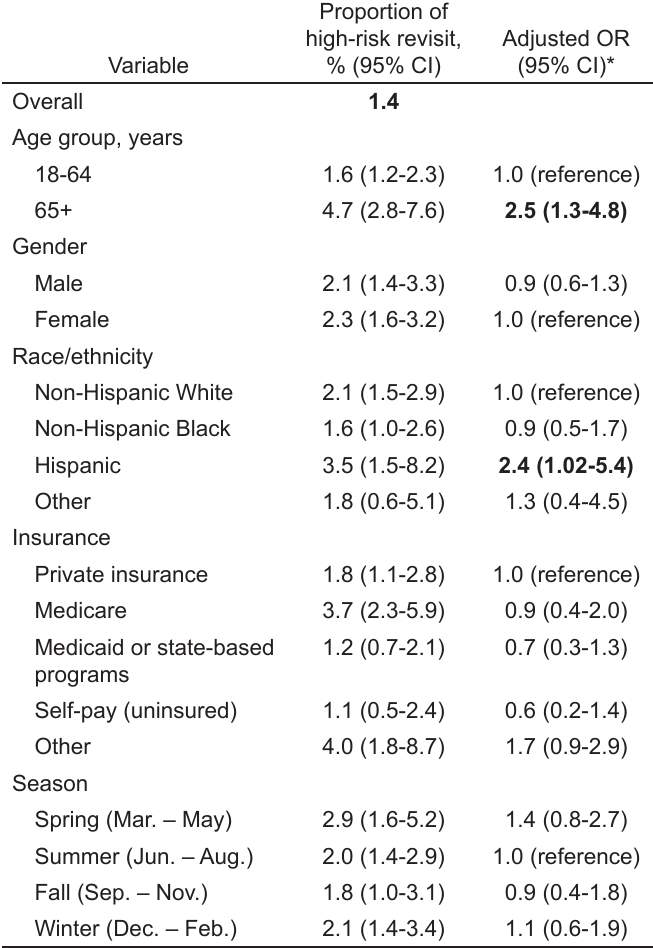
*Multivariable model adjusts for all variables in the table. Significant odds ratios are highlighted in